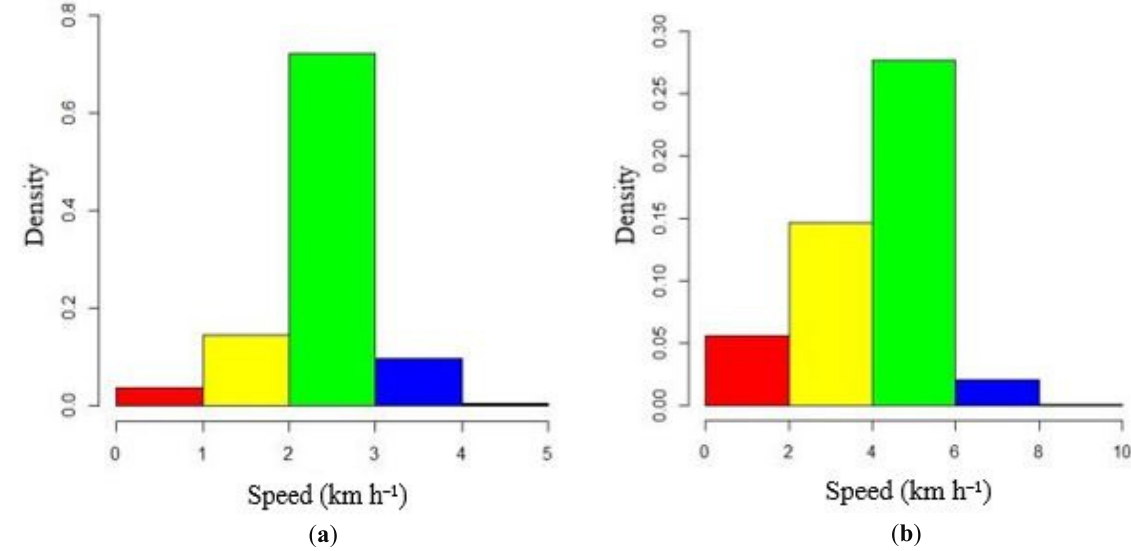
Figure 4. Histogram of speed by R: ( a ) medium combine (Model: ER329); ( b ) large combine (Model: ER6120).